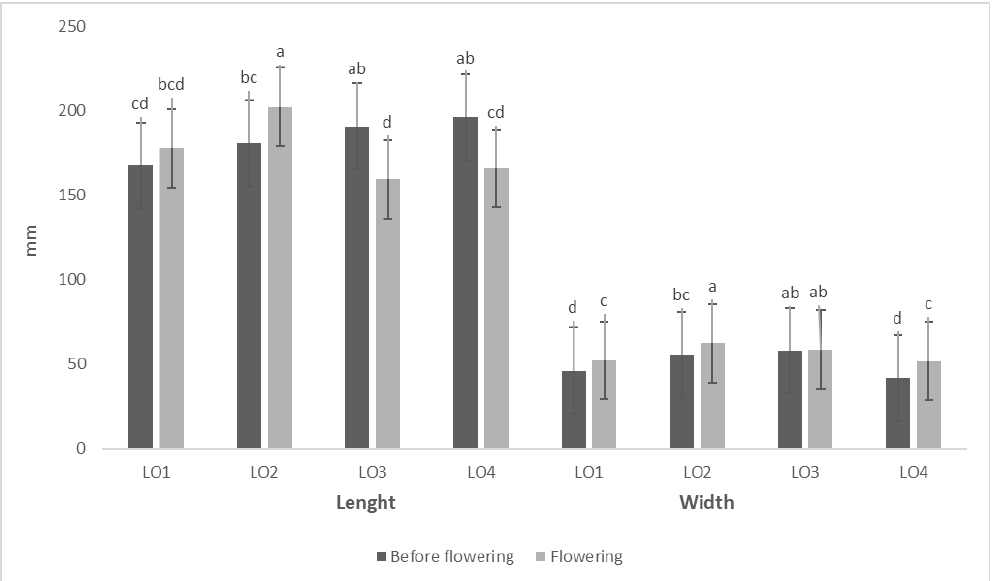
Figure 4. Morphological characteristics (length and width) of wild garlic leaves from four different locations (LO 1–LO 4) before and in flowering stage. Different letters indicate significant differences between mean values at p ≤ 0.0001. Significance of interaction for leaf length: L–location p ≤ 0.0267; P—phenophase p ≤ 0.1147; L × P—location and phenophase p ≤ 0.0001, and leaf width: L—location